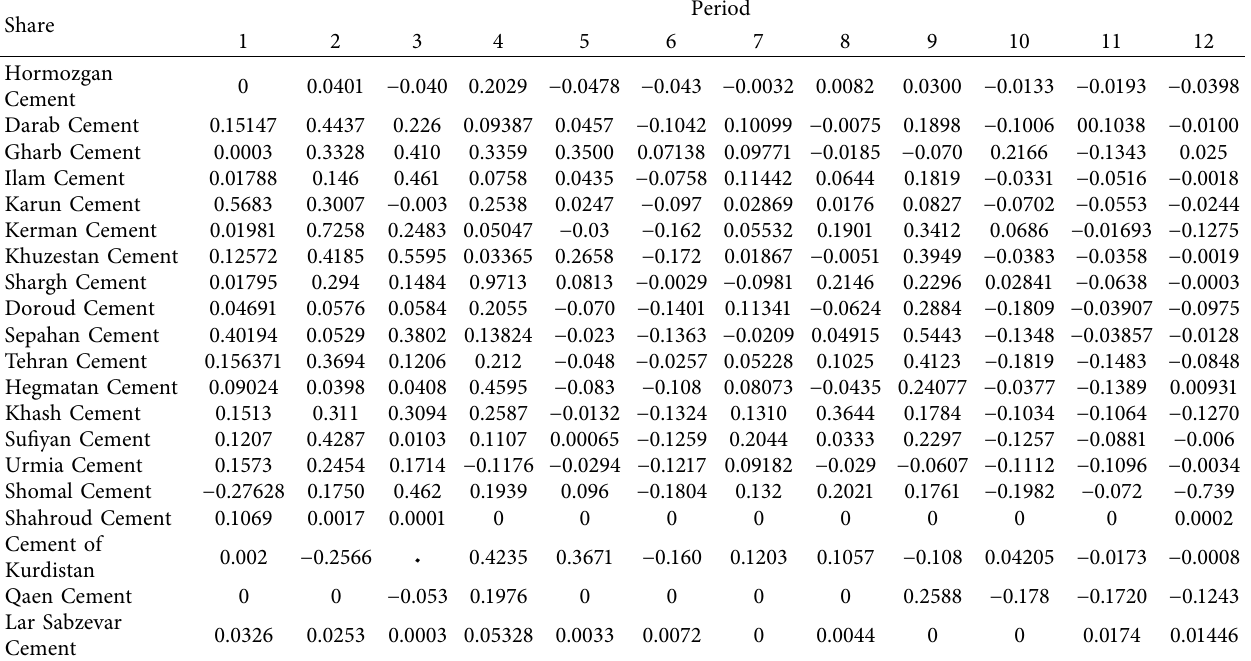
Table 1: Summary of the problem data.